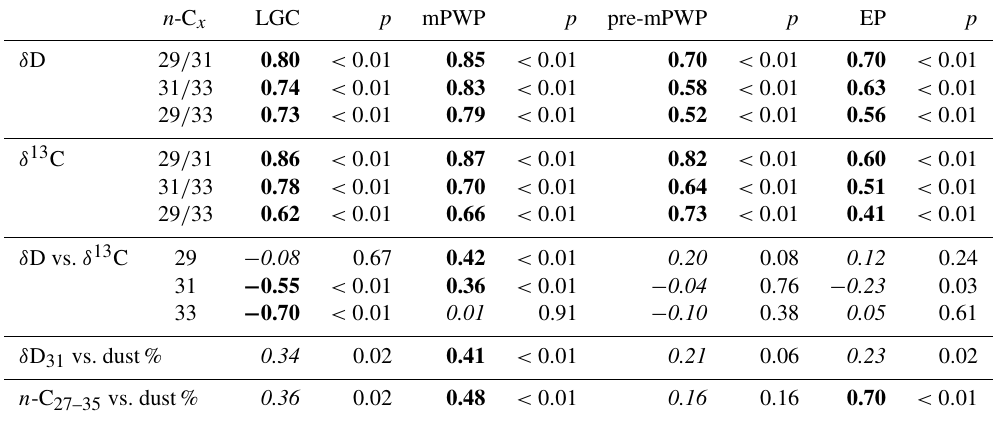
Table 1. Correlation coefficients ( r ) and ( p ) for plant-wax-specific stable isotopes ( δ D, δ 13 C), long-chain n alkane ( n -C x ) and dust percent- ages at ODP Site 659.